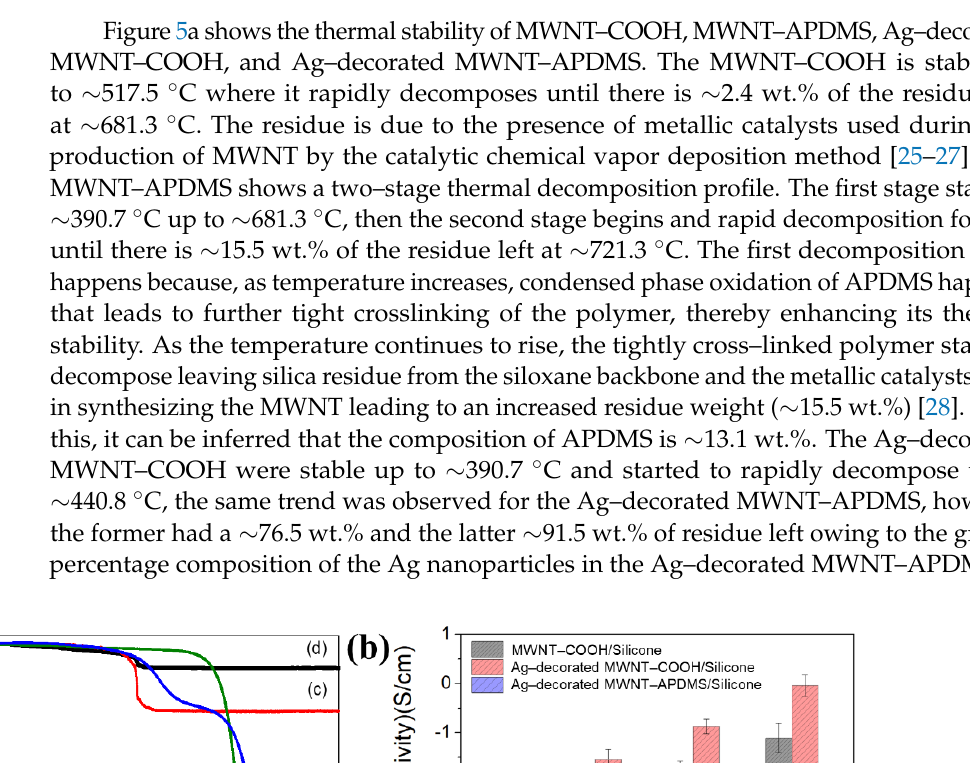
Figure 4. TEM images for ( a ) Ag–decorated MWNT–COOH and ( b ) Ag–decorated MWNT–APDMS. The average size of silver nanoparticles is ~8 nm.